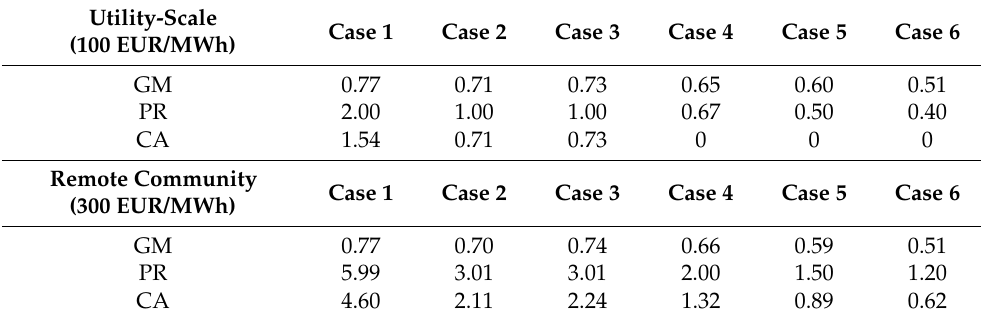
Table 12. Wave energy